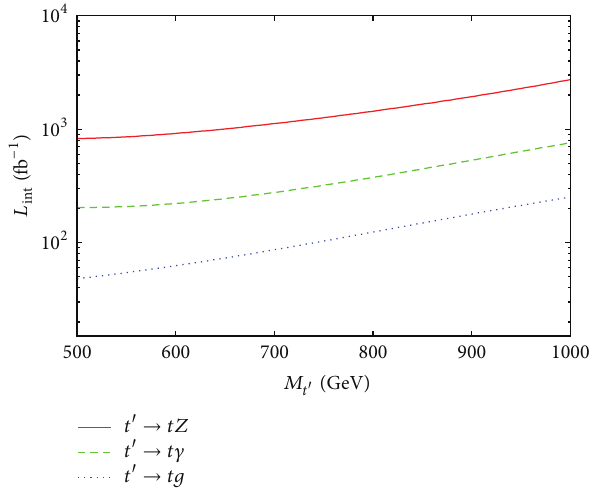
Figure 6: The same as Figure 5, but for parametrization PII.